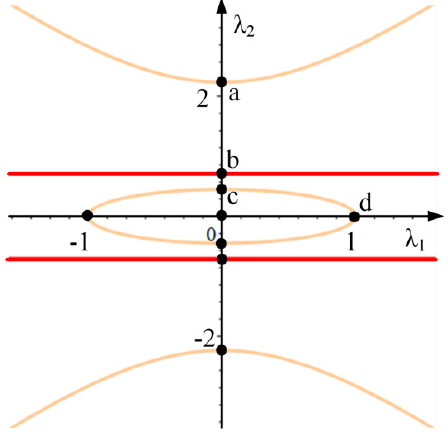
as shown in Figure 11.